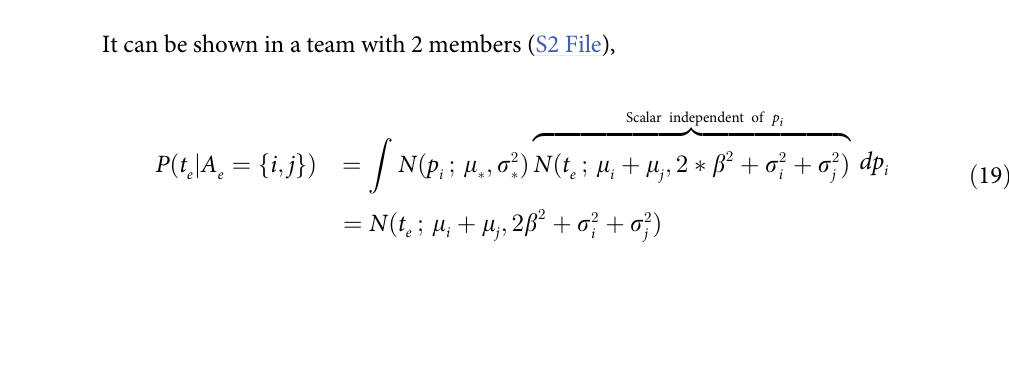
Fig 8. Performance distributions, N ( p i ; s i , β 2 ) weighted by the probability of the skill belief distribution N ð s solid line must be integrated to compute a certain probability p